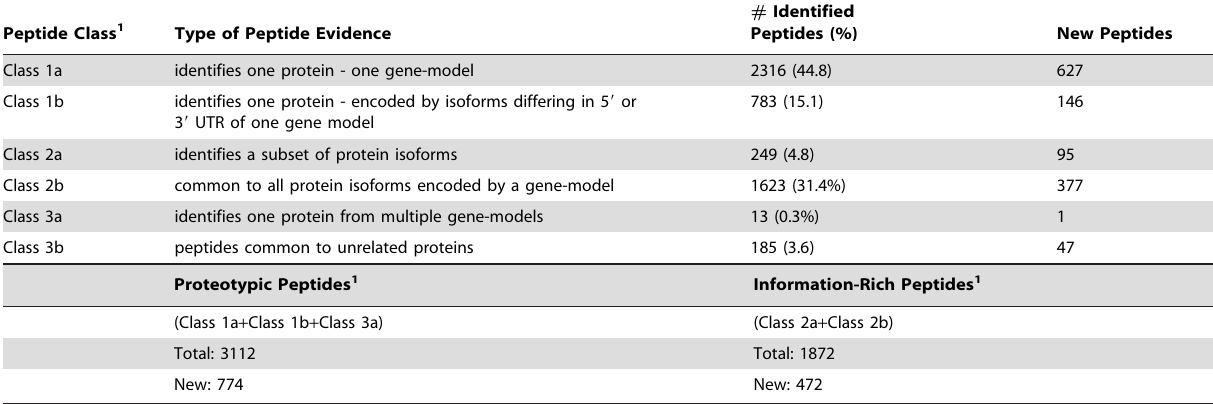
Table 1. Drosophila Cardiac